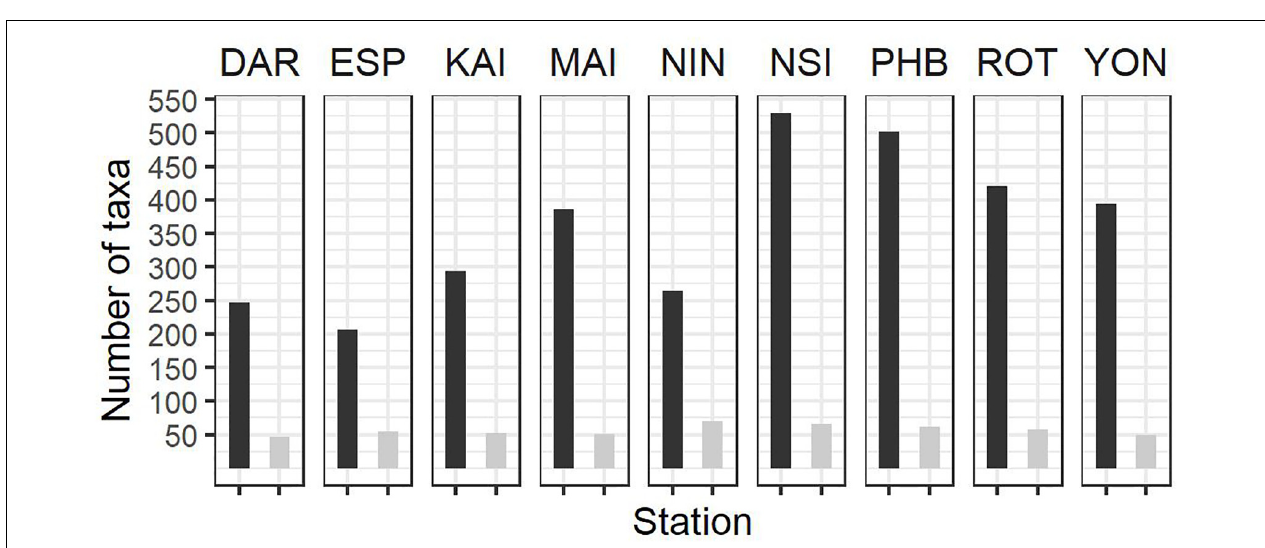
FIGURE 4 | Summary of zooplankton count data at the NRS (dark bars, total number of taxa per station; light bars average number of taxa per sample) since IMOS commenced network observations. See Table 1 for start date of IMOS plankton time series at each location. DAR, Darwin ( n = 31); ESP, Esperance ( n = 17); KAI, Kangaroo Island ( n = 41); MAI, Maria Island ( n = 100); NIN, Ningaloo ( n = 12); NSI, North Stradbroke Island ( n = 114); PHB, Port Hacking ( n = 179); ROT, Rottnest Island ( n = 91); YON, Yongala ( n = 98 where n = number of samples counted at each